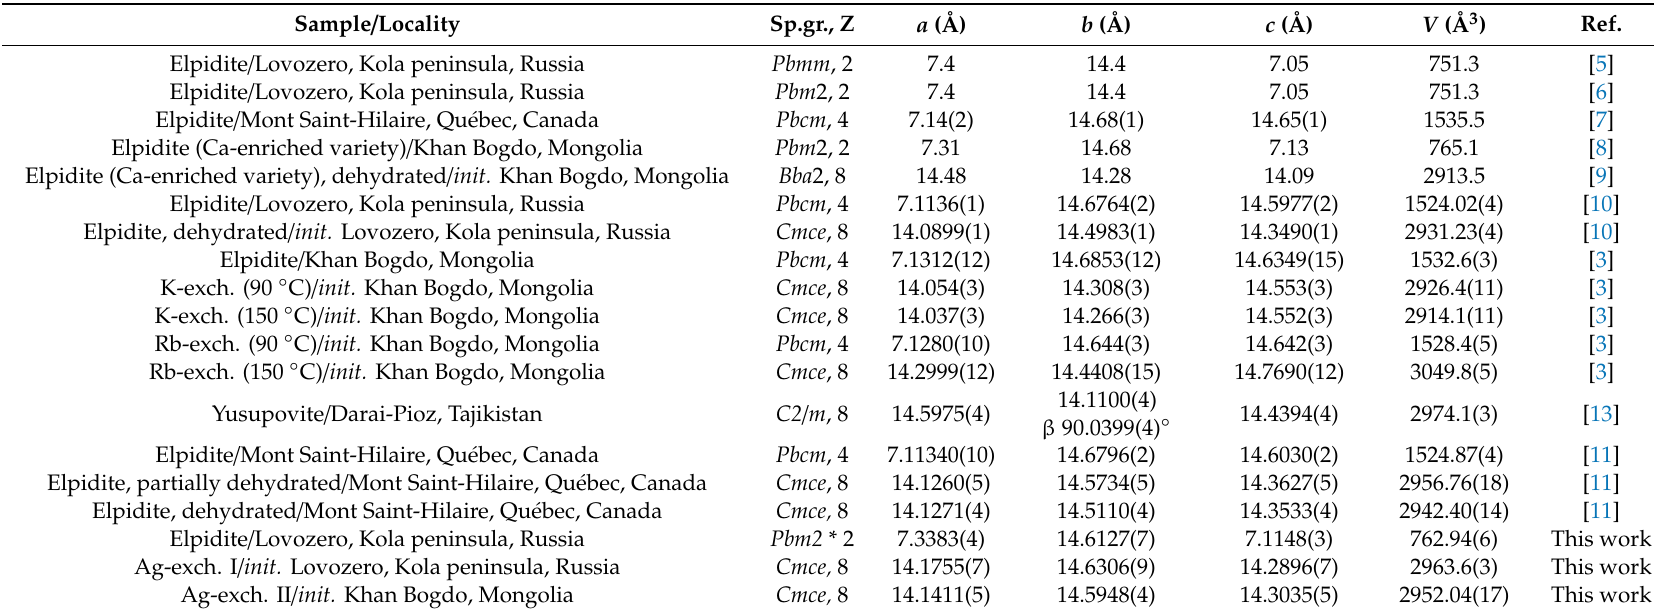
Table 1. Some crystallographic data for elpidite, related mineral yusupovite and laboratory-modified forms of elpidite. Sample /